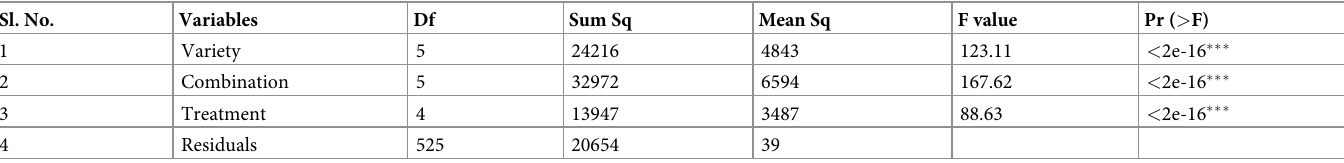
Table 7. ANOVA results for callus induction. Sl. No.